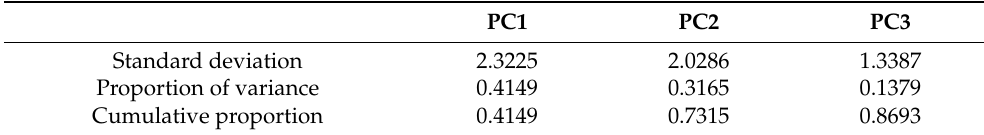
Table 3. Results of the principal component analysis with information about the three utilized principal